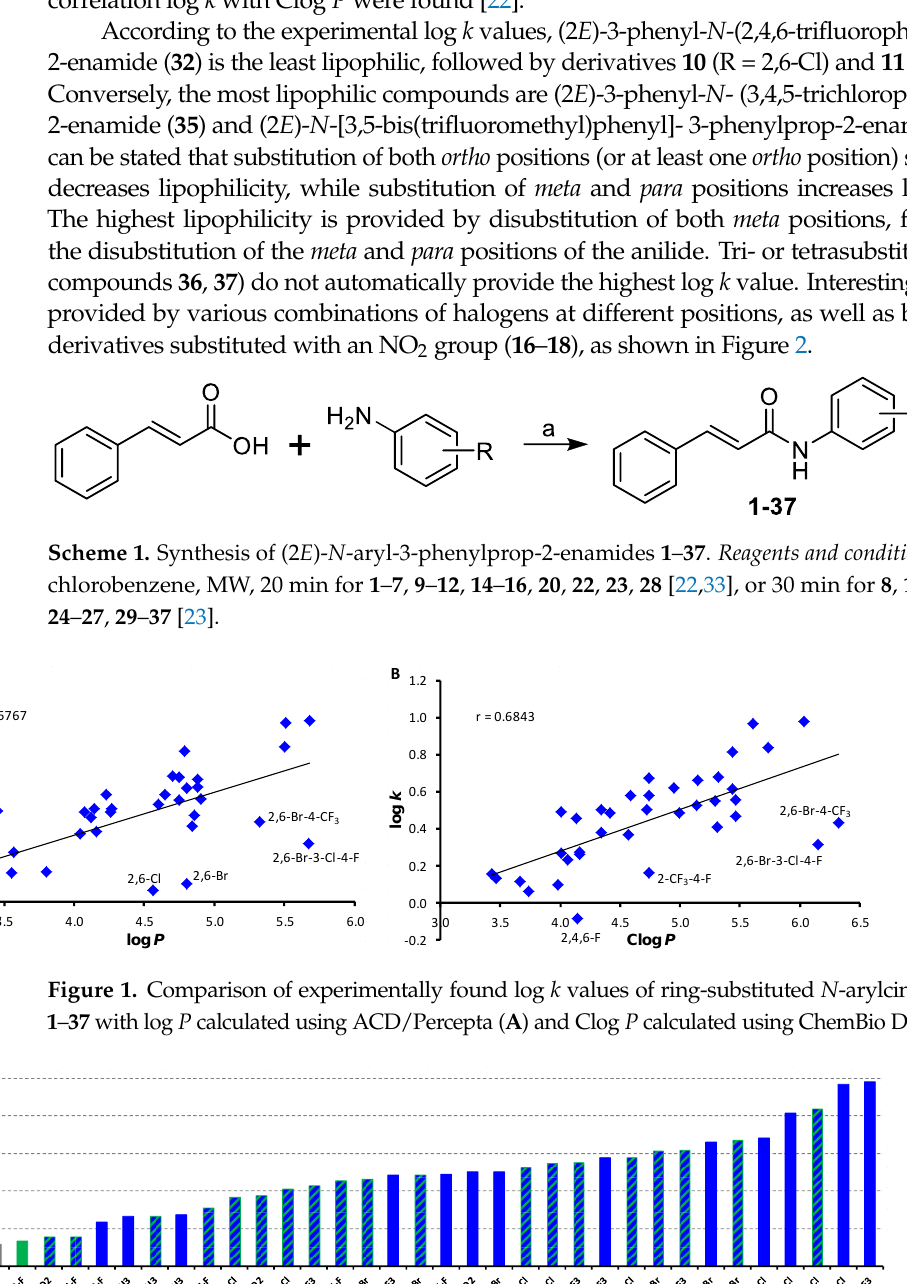
Figure 2. Order of individual derivatives arranged according to increasing log k values. (Grey = unsubstituted 1 , green = ortho -substituted derivatives, blue = meta/para -substituted derivatives, green/blue hatched = derivatives with meta / para- and ortho -substitutions.)